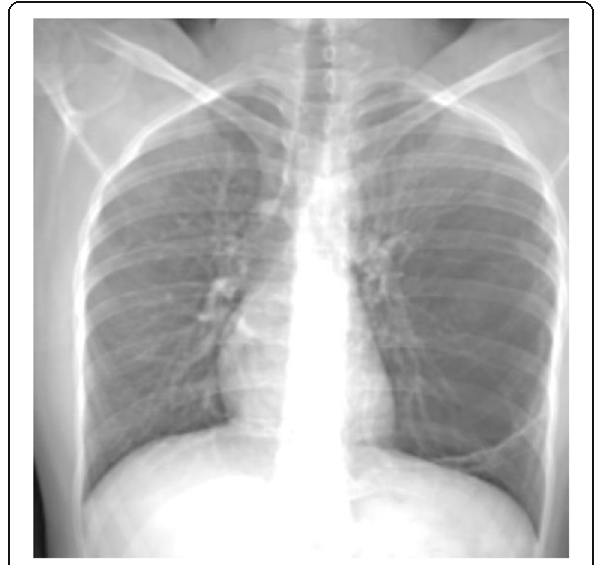
Fig. 1 CT scout radiograph showed increased radiolucency involving mid and lower zones of the left lung with displacement of broncho- vascular markings with mild mediastinal to right